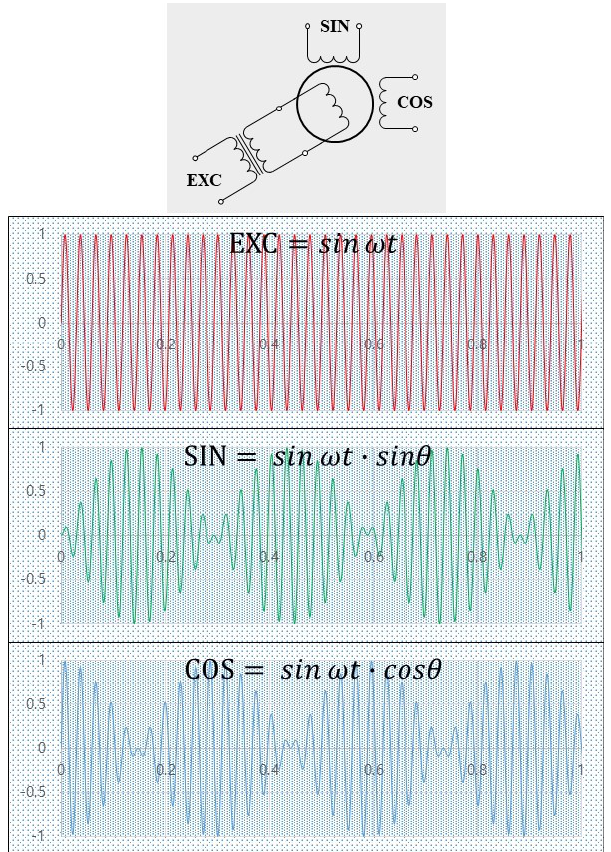
Figure 2. Characteristics of